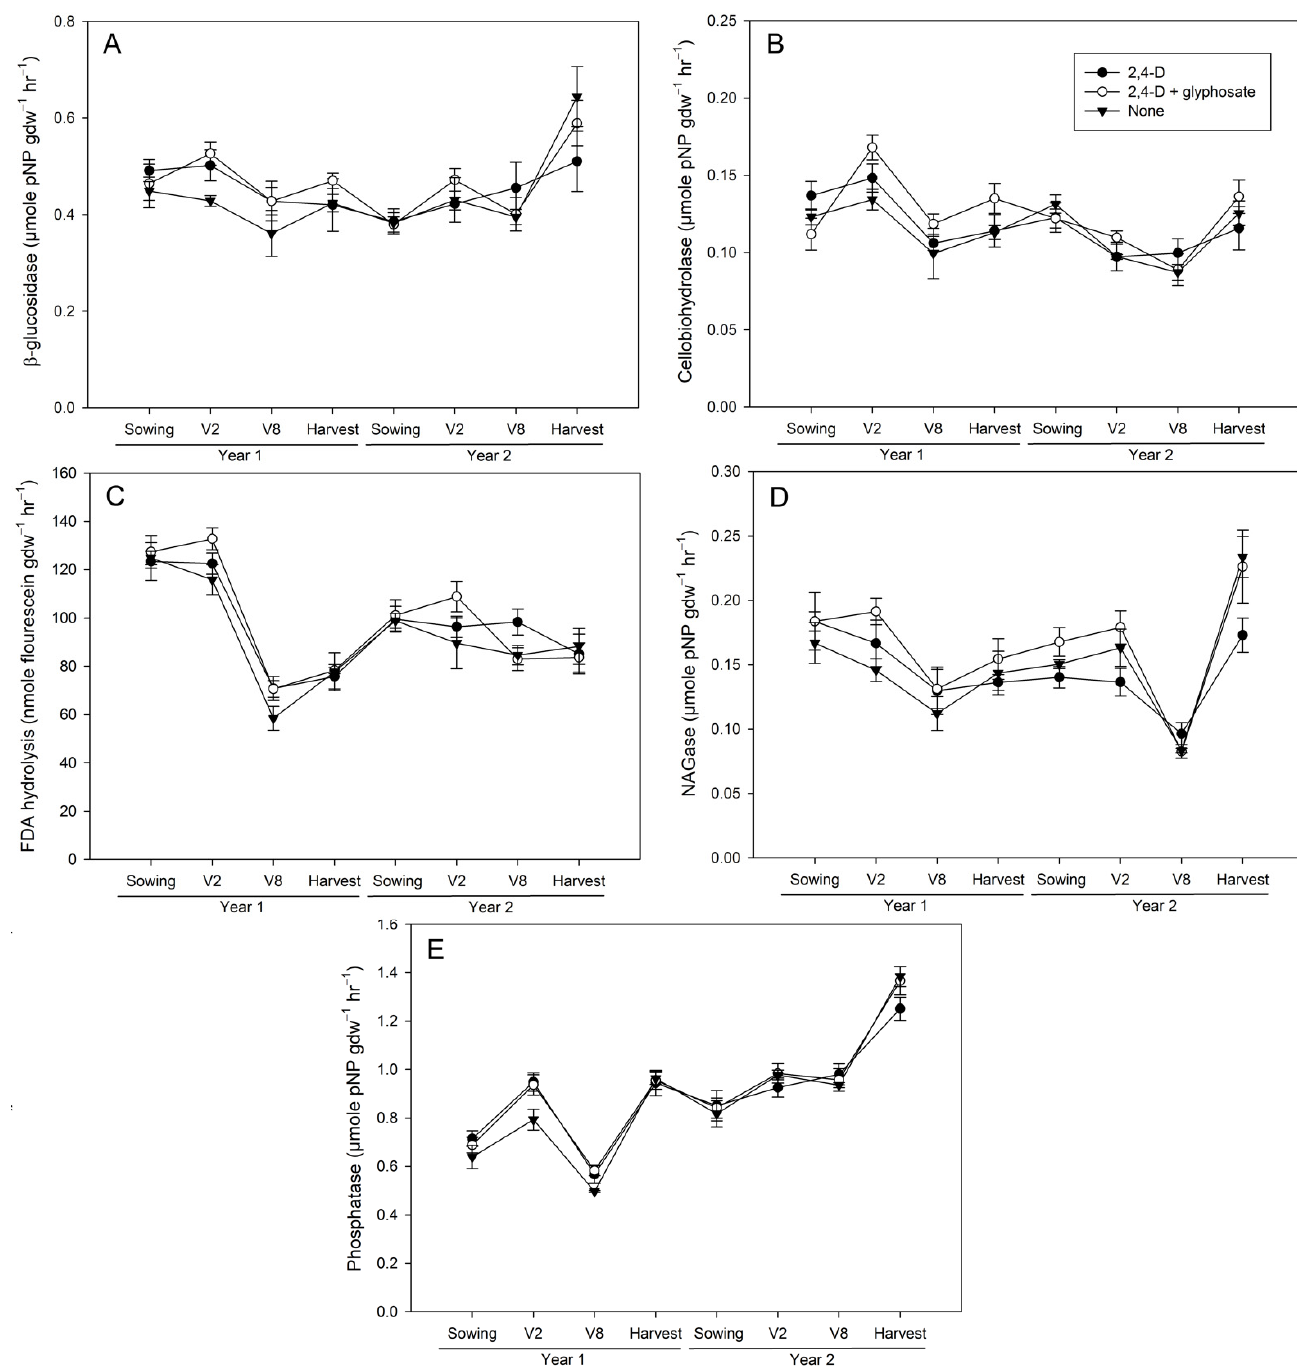
Figure 2. Activity of beta-glucosidase ( A ), cellobiohydrolase ( B ), fluorescein diacetate (FDA) hydrolysis ( C ), N-acetylglucosaminidase (NAGase)( D ), and phosphatase ( E ) in 0–5 cm soil from 2,4-D-only (closed circle), 2,4-D+glyphosate (open circle), and untreated control (closed triangle) plots for each timepoint during the two-year study. Values represent mean ± standard error (n = 4).